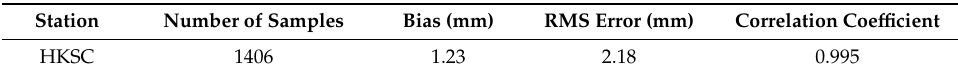
Table 2. Bias, RMS error and correlation coe ffi cient between the time series of GNSS-PWV and RS-PWV shown in Figure 2.